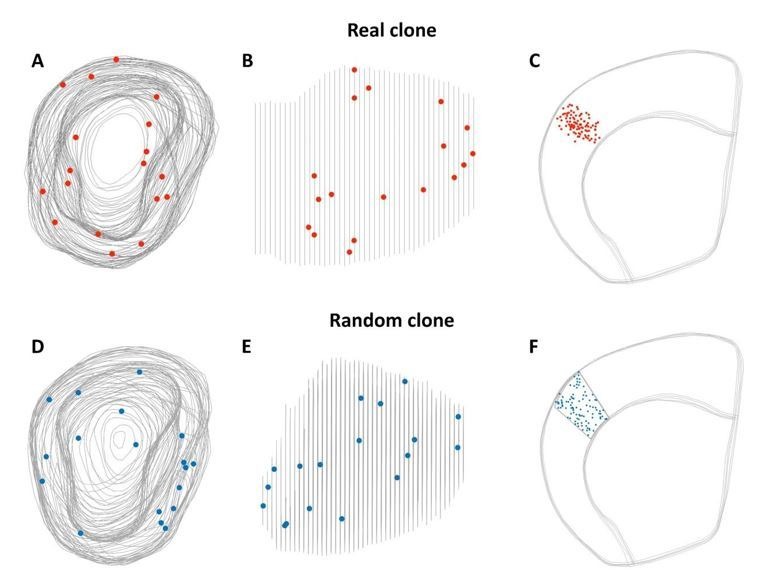
Volume for random dataset in the olfactory bulb and neocortex.(A-C) 3D reconstruction from clones observed in OB (A-B) and neocortex (D) on our E10.5 experiment. (D-F) 3D reconstruction used to generate the random data set in the OB (D-E) and the neocortex (F).